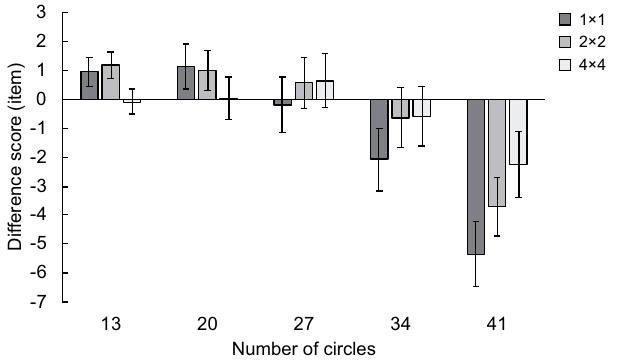
Figure 4. Mean difference scores for target numerosities, separated according to the factor of divider. Error bars represent standard